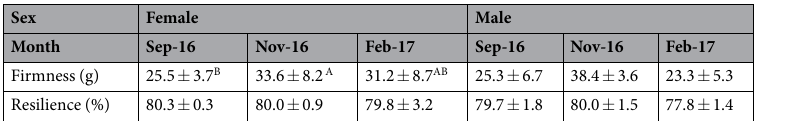
Table 4. Firmness (g) and resilience (%) of P . lividus gonads (ovary and testis) collected at Praia Norte (Portugal) at three distinct periods. Values are mean ± standard deviation; per month the 18 individuals were pooled by sex: N = 3 pools of female gonads and N = 3 pools of male gonads were established. Within a row, superscripts in capital letters ( ABC ) indicate significant differences between months (P <